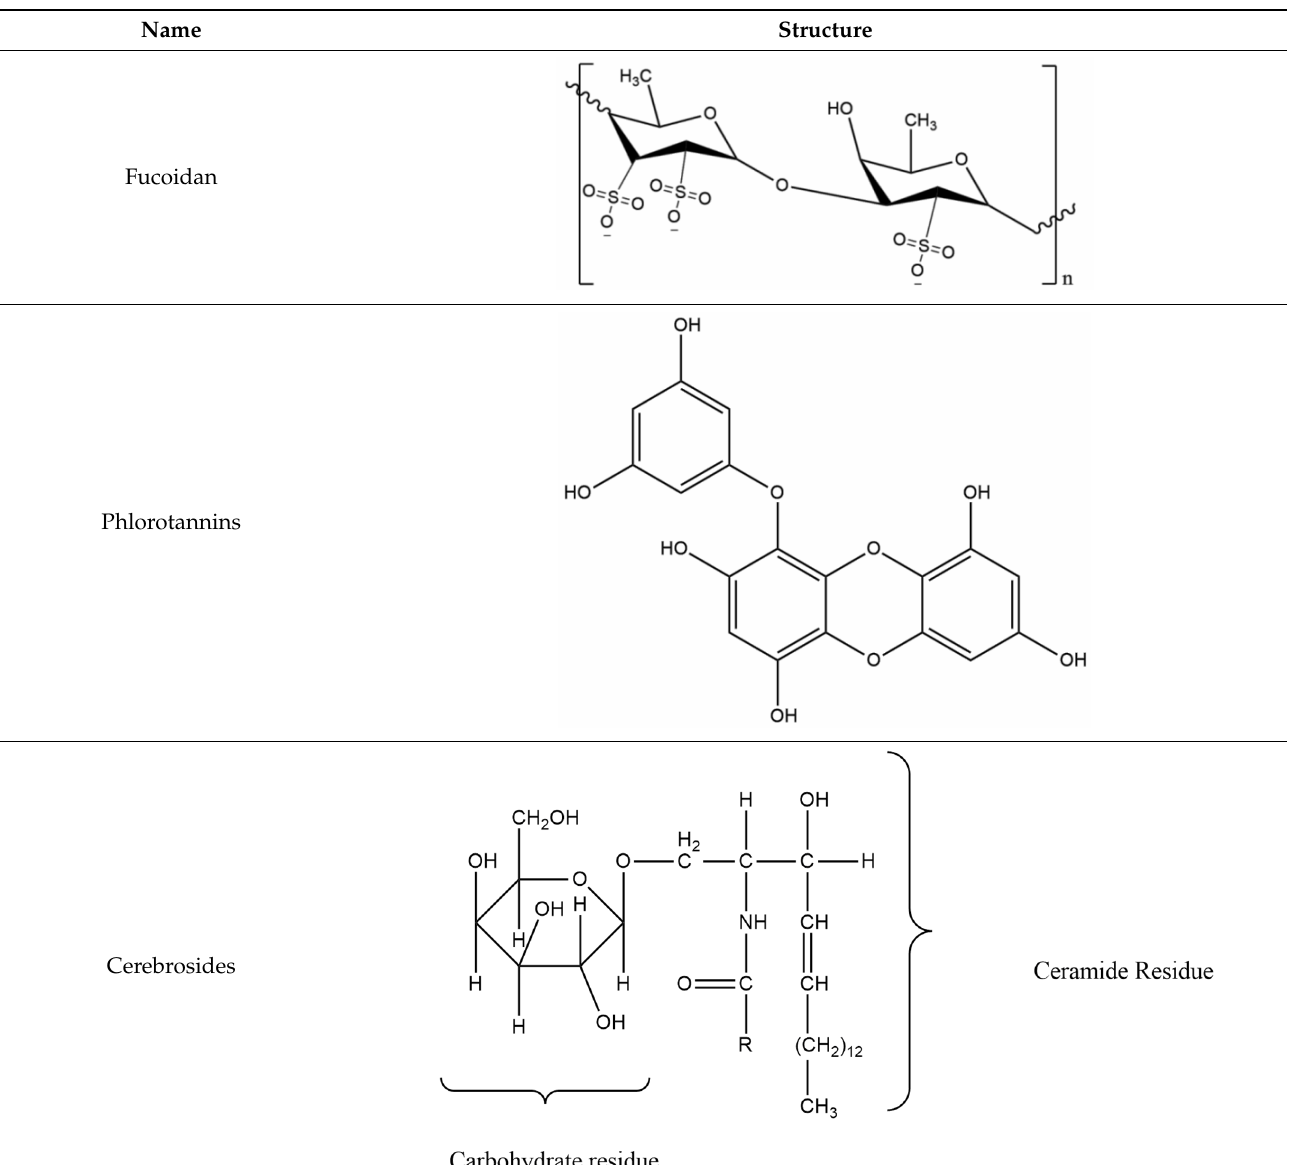
Table 4. The below table lists the marine drugs used in neurodegenerative diseases with their respective structures.